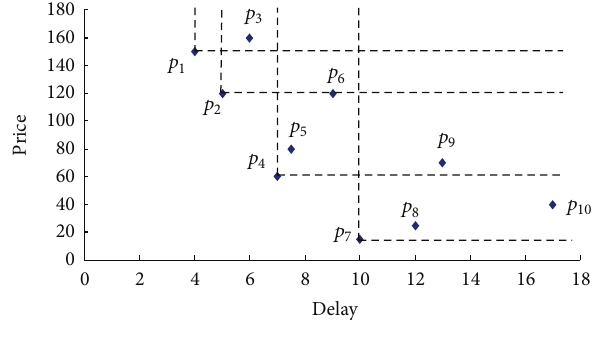
Figure 4: Skyline